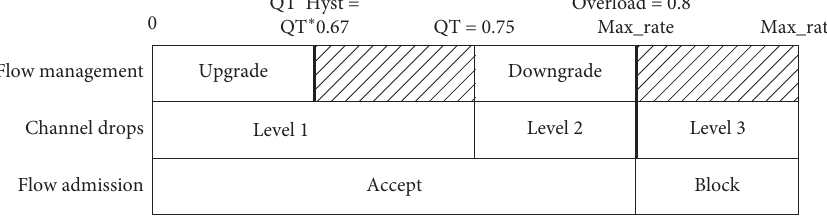
Figure 2: Decision thresholds for the brokerage service.